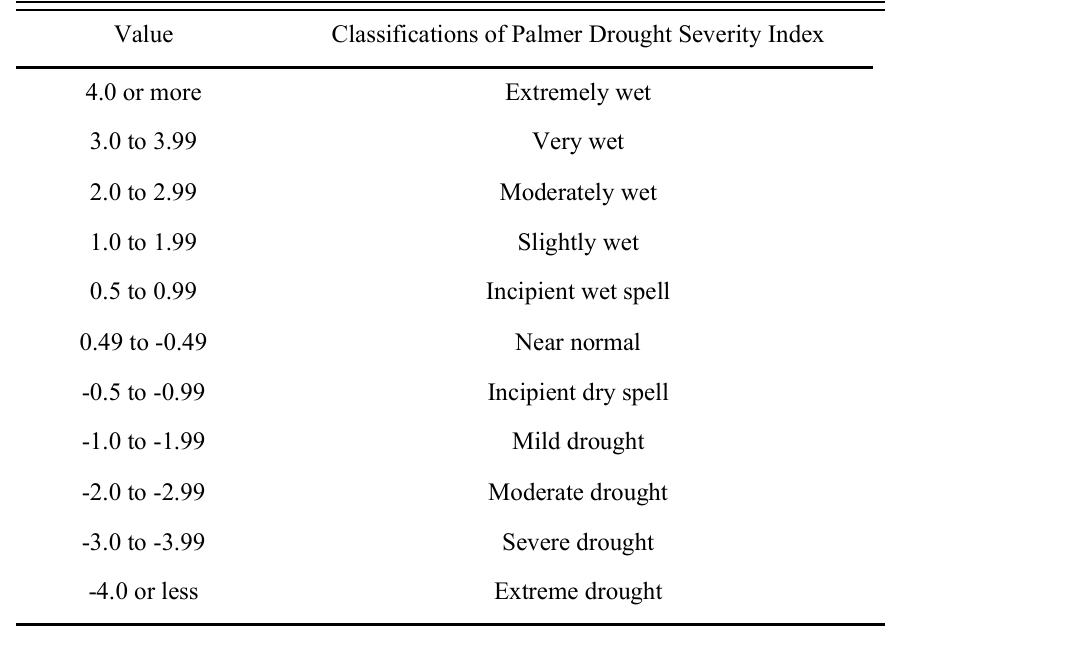
Table 1. Classifications of Palmer Drought Severity